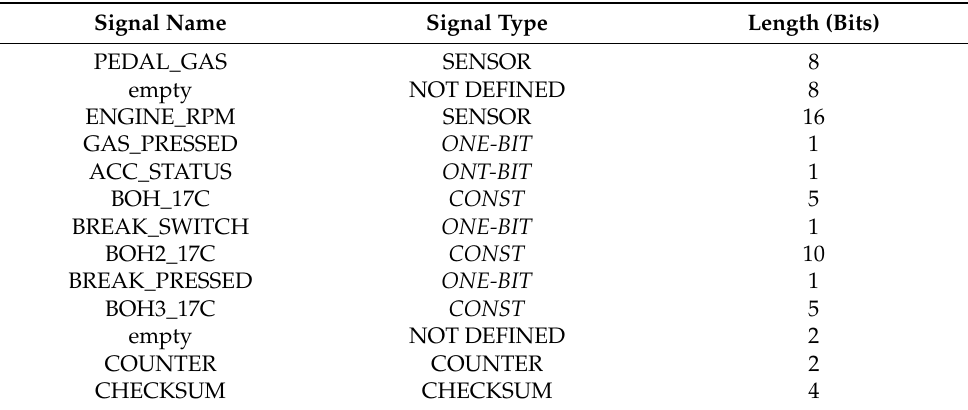
Table 4. Example of signals included in a CAN ID of the real CAN trace.